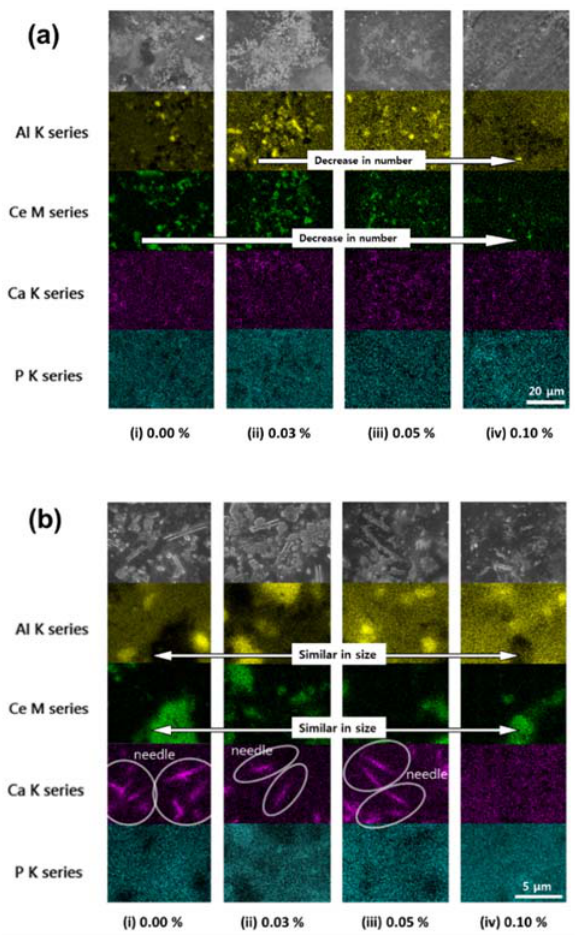
Figure 5. FESEM images and corresponding EDS analysis (Al, Ce, Ca, and P) for enamel-coated surface with the addition of ZrO 2 at ( a ) low and ( b ) high magnification.